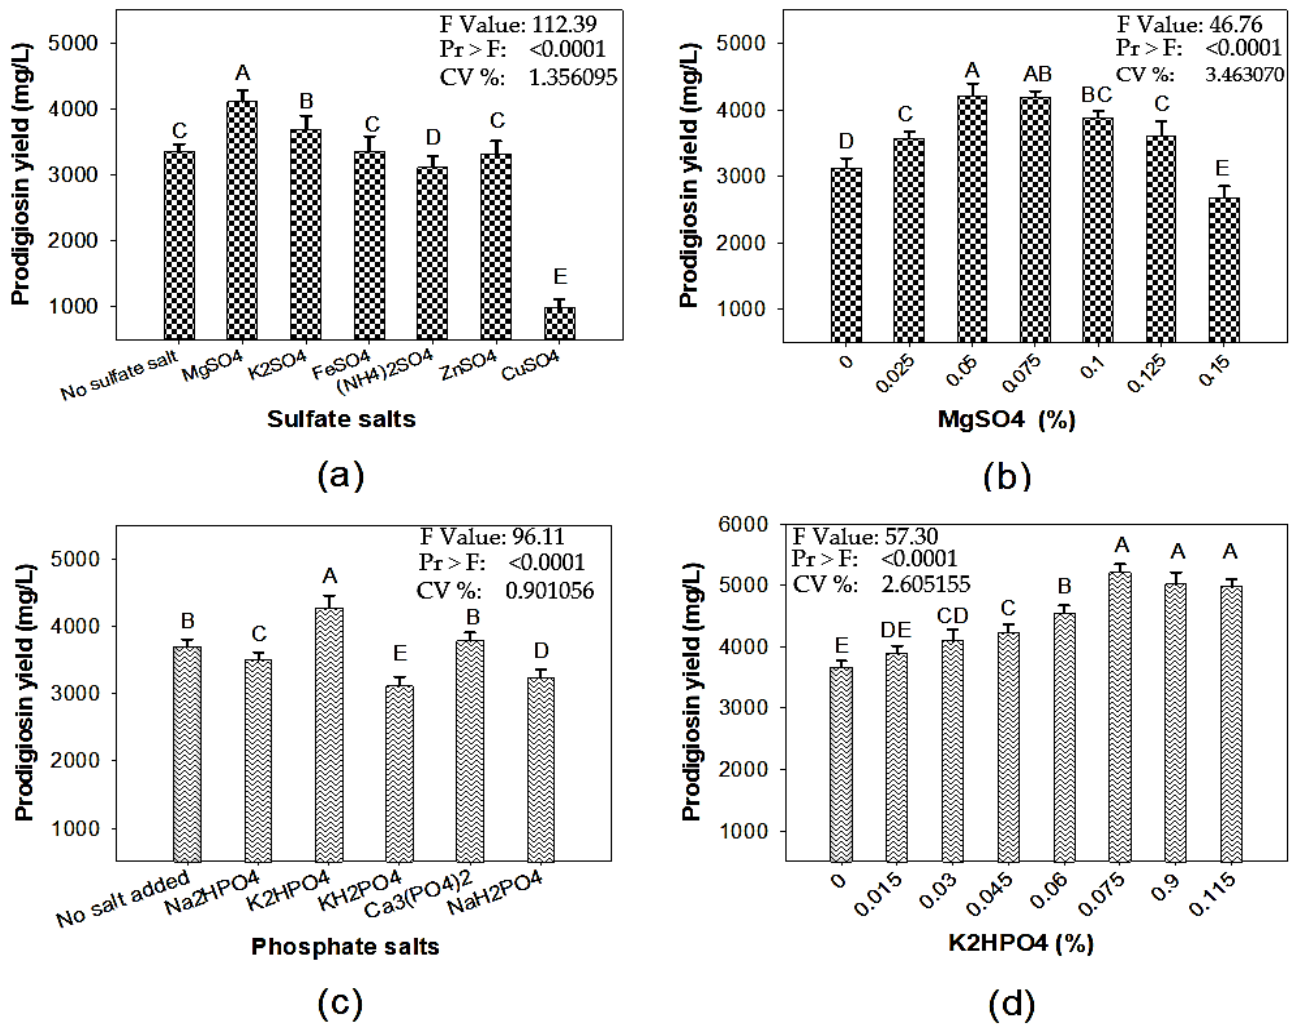
Figure 2. The effects of different kinds of sulfate salts ( a ), supplementary MgSO 4 concentration ( b ), different kinds of phosphate salts ( c ), and supplementary K 2 HPO 4 concentration ( d ) on prodigiosin biosynthesis using S . marcescens TNU01 from a medium based on cassava wastewater. All experiments were conducted in triplicate. The data were analyzed via the simple variance (ANOVA), then Duncan′s multiple range test was conducted at p = 0.01. Means of prodigiosin yield values with the same letter in each figure are not significantly different. Standard errors (SD) are shown as error bars .